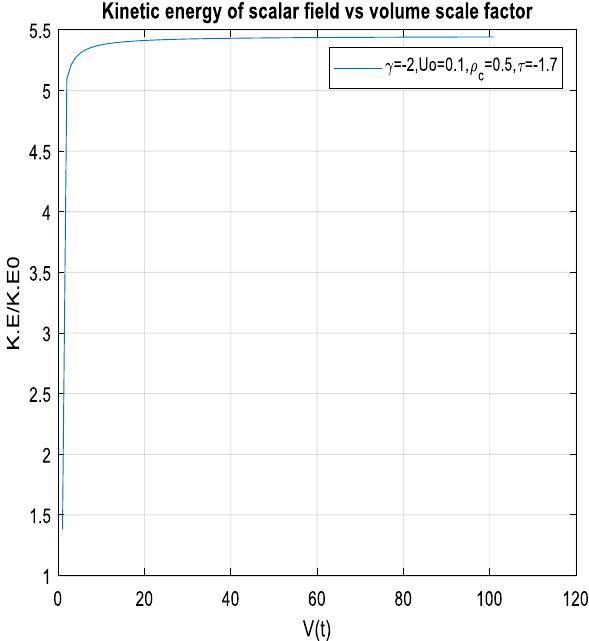
Fig. 22 Graph for kinetic term in fields; w = − 2 −